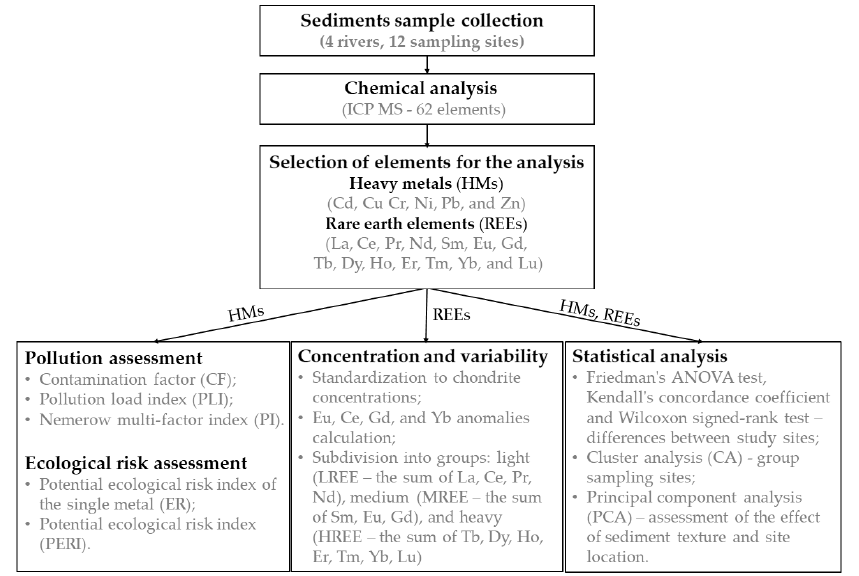
Figure 1. Flow chart of research methodology.